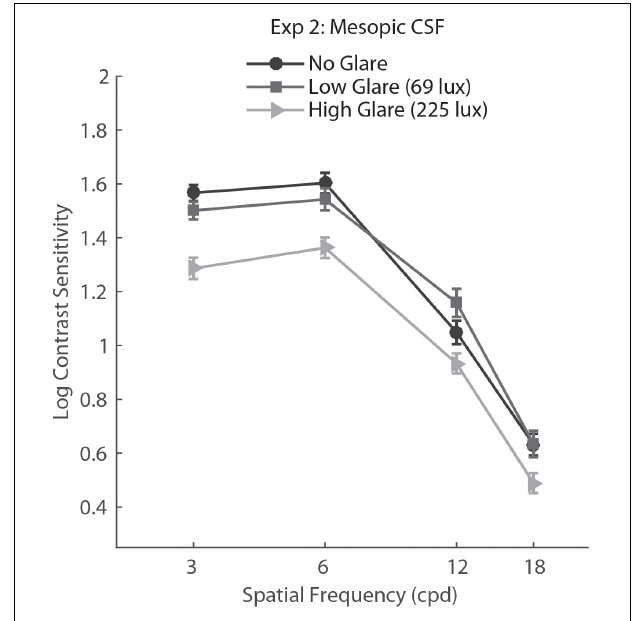
FIGURE 2 | Contrast sensitivity function in photopic viewing for glare and no glare condition (69 lux) tested with CSV-1000E. Error bars represent standard error (SEM).